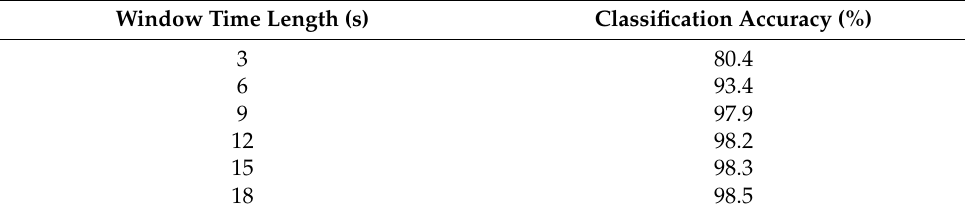
Table 5. The classification accuracy of the proposed